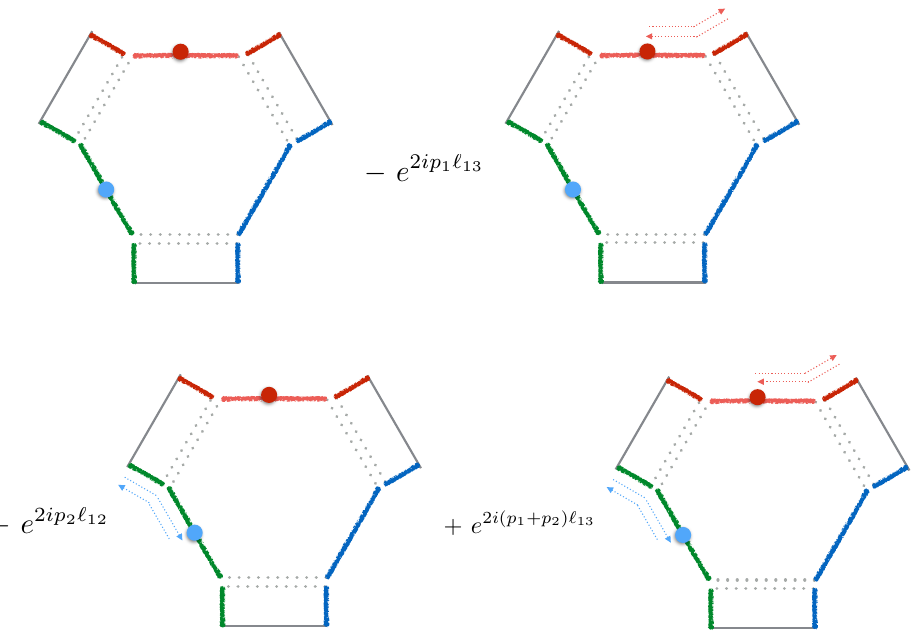
Figure 11 . By appropriate propagation factors e 2 ip 1 ‘ 13 and e 2 ip 2 ‘ 12 , the each terms can be inter- preted as the each magnon with ( p 1 ; p 2 ) ; (